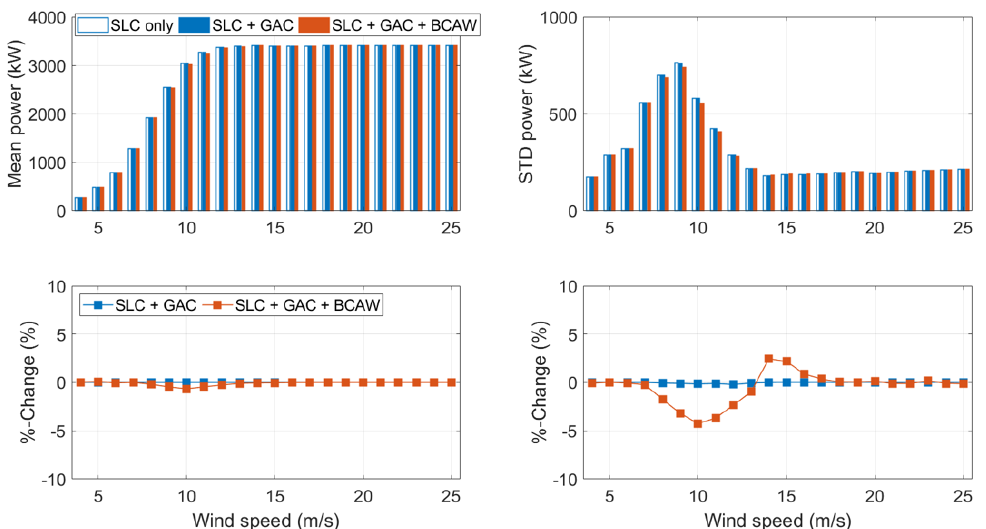
Figure A1. Variation of the mean and standard deviation of the power from cut-in to cut-out wind speed under DLC 1.2 with different control architectures. Top—Dimensional values; Bottom— Percentage changes with respect to the ‘SLC Only’